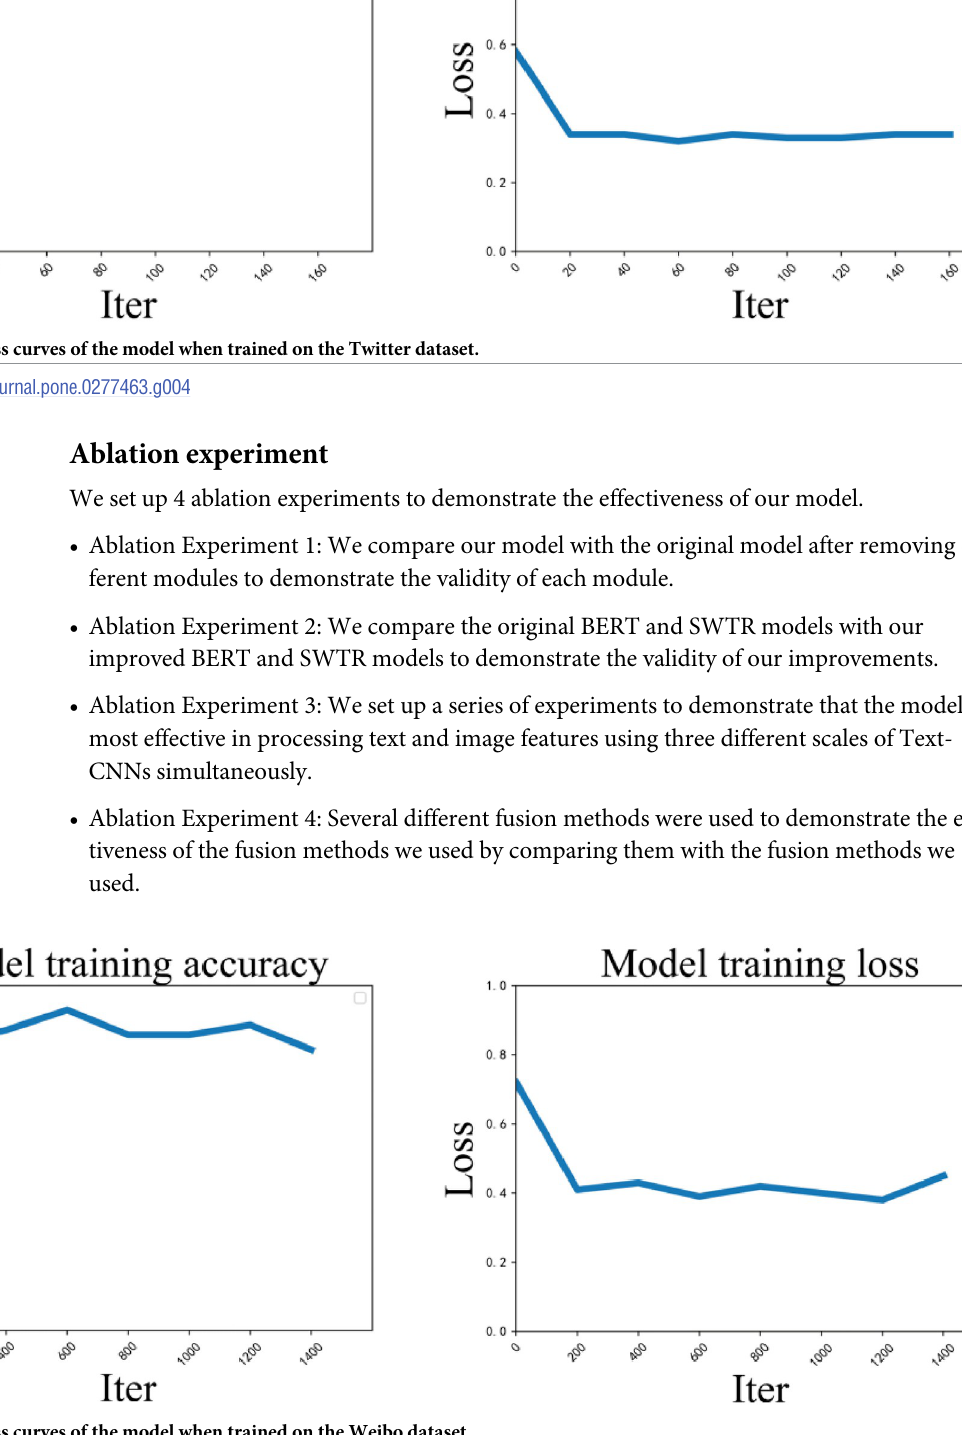
Fig 5. Accuracy and loss curves of the model when trained on the Weibo